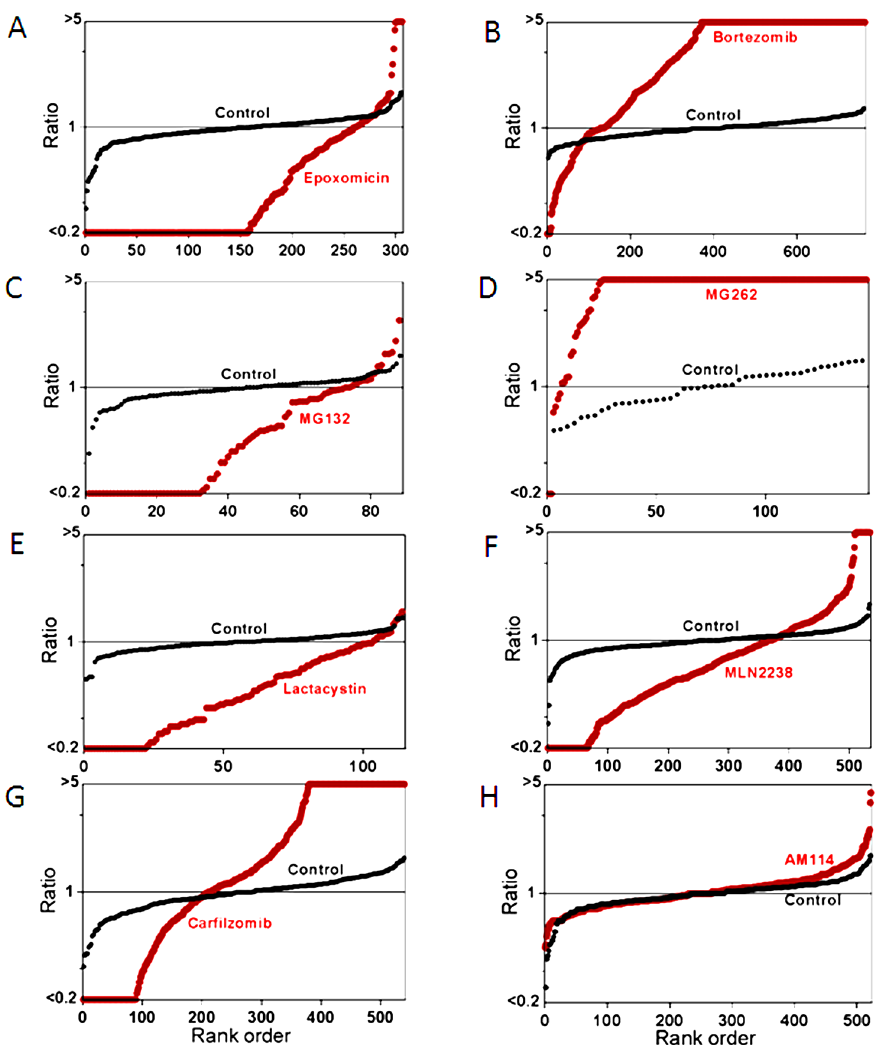
Figure 3. Summary plots of the peptidome of HEK293T cells in response to proteasome inhibitors. The relative level of all the peptides identified by MS/MS analysis in each of the drug-treated replicates was compared to the average level of the peptide in the untreated control replicates. The y-axis represents the relative peptide levels (log-scale) sorted from low to high and the x-axis represents the rank order of each peptide sorted according to the relative level. When a peptide is detected in multiple charged states, the peptide ratio for each peptide is indicated separately. If the ratio was , 0.20 or . 5.0 between the drug-treated and control replicates, the value was capped at 0.20 or 5.0. Each panel shows two plots; one shows the peptide level of each replicate of the identified peptides in drug-treated cells, expressed relative to the average control value (red circles), the other shows the peptide level of each control replicate expressed relative to the average control value (black circles). Panels A–H represent data from experiments on HEK 293T cells treated with (A) 0.2 m M epoxomicin for 1 hour, (B) 0.5 m M bortezomib for 1 hour, (C) 2.5 m M MG132 for 35 min, (D) 1 m M MG262 for 35 min, (E) 1 m M clasto-Lactacystin b -lactone for 35 min, (F) 1 m M MLN2238 for 35 min, (G) 1 m M carfilzomib for 35 min, (H) 1 m M AM114 for 35 min. The data used to generate the plots shown in panels A and B were previously published